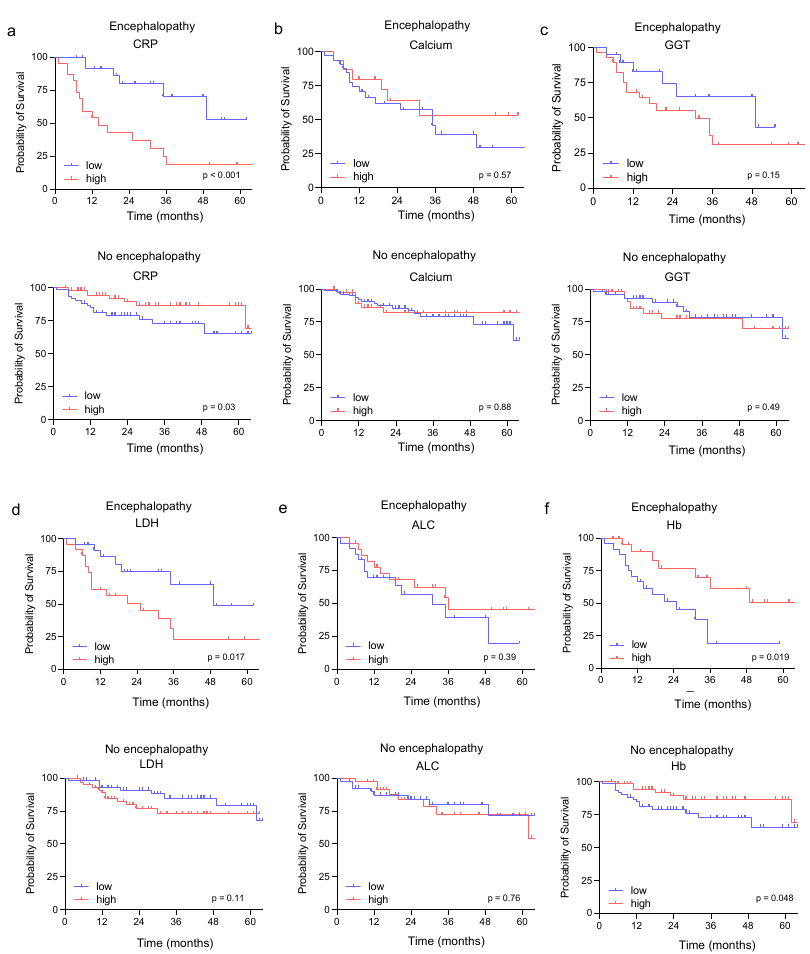
Figure 4. Prognostic role of the identified risk factors in sarcoma patients. Kaplan–Meier curves showing the influence of CRP ( a ), calcium ( b ), GGT ( c ), LDH ( d ), ALC ( e ), and HB levels ( f ) in patients with and without IIN and probability of survival. IIN = ifosfamide-induced neurotoxicity; CRP = C-reactive protein; GGT = gamma-glutamyl transferase; ALC = absolute lymphocyte count; Hb = hemoglobin level; LDH = lactate